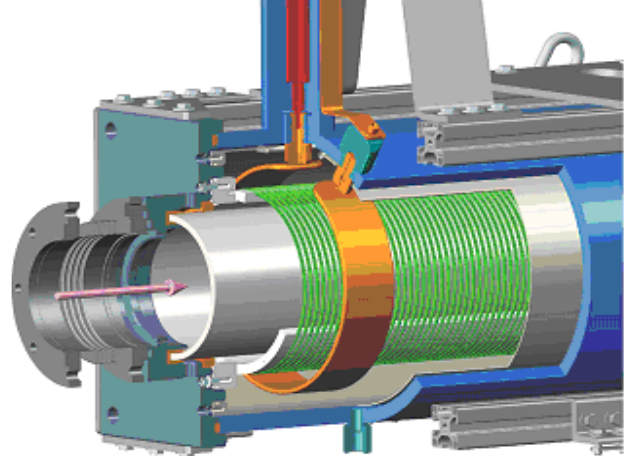
FIG. 7. (Color) One turn transformer drive illustrated on the oil helix [2]. The helix wire (green) is grounded to the outer conducting tube on the left side. (Figure courtesy Matthaeus